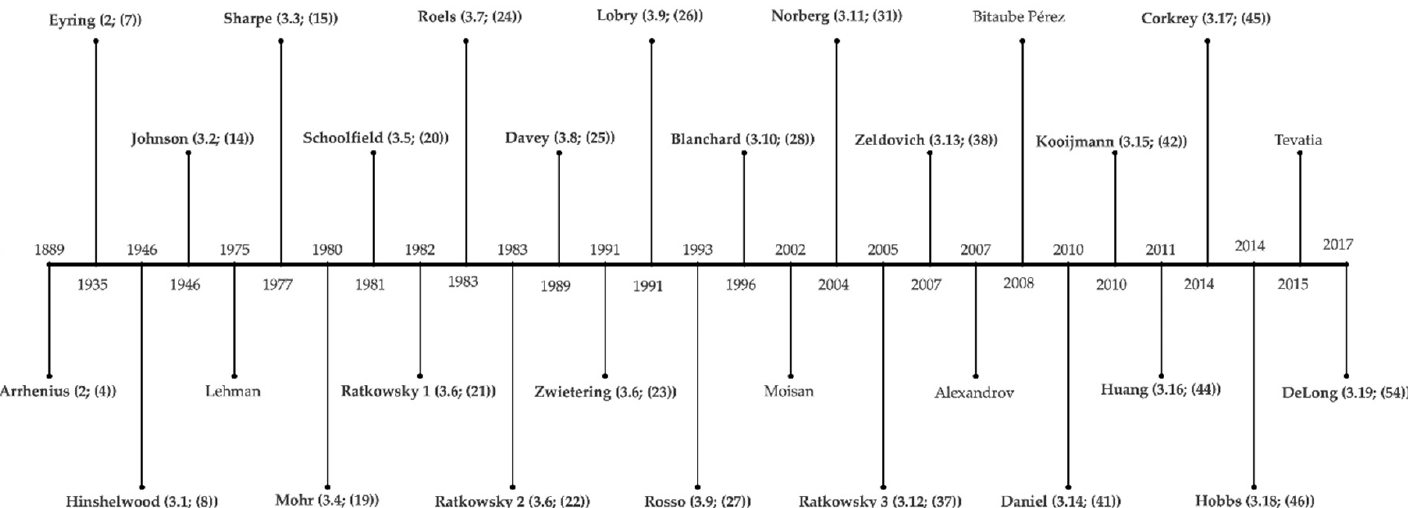
Figure 1. Timeline of temperature models described in paragraphs 2–3 starting in 1889 with the semi-empirical Arrhenius model. First author of the described model (paragraph number; equation number). Models marked with bold letters are described in detail and the remaining models in non-bold letters are summarized in paragraph 3.20, Table 1.